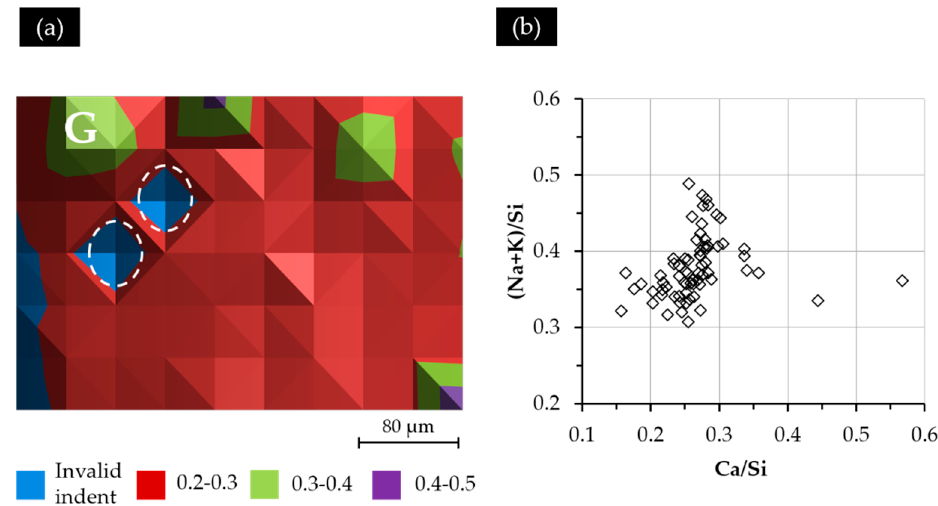
Figure 13. ( a ) The Ca/Si ratio variation of the indented areas from S3; ( b ) the elemental composition of the indented areas.